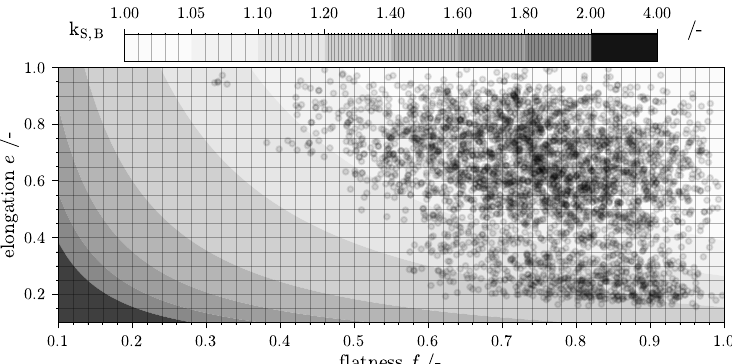
Figure 10. Heatmap of drag correction factor k S,B for ellipsoids versus their elongation and flatness based on Equation (9) found in